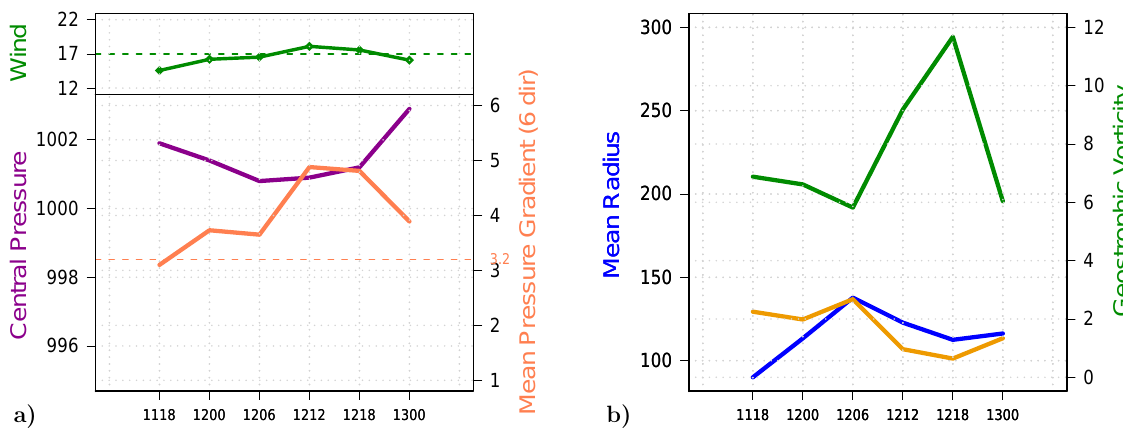
Fig. 9. Evolution over time of (a) gradient wind (ms − 1 ) in green (top) and central pressure (hPa) in violet + mean pressure gradi- ent (10 − 2 hPakm − 1 ) in orange (bottom); (b) mean radius (km) in blue + mean warm core radius (km) in orange + geostrophic vorticity (10 − 4 s − 1 ); for 1996